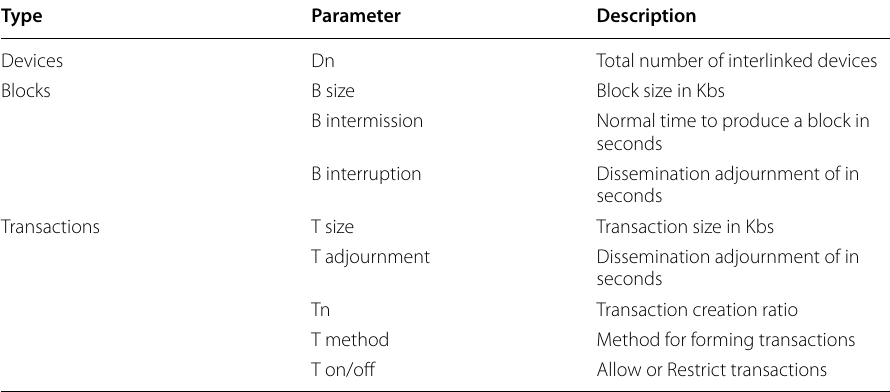
Table 4 Input considerations for the emulator